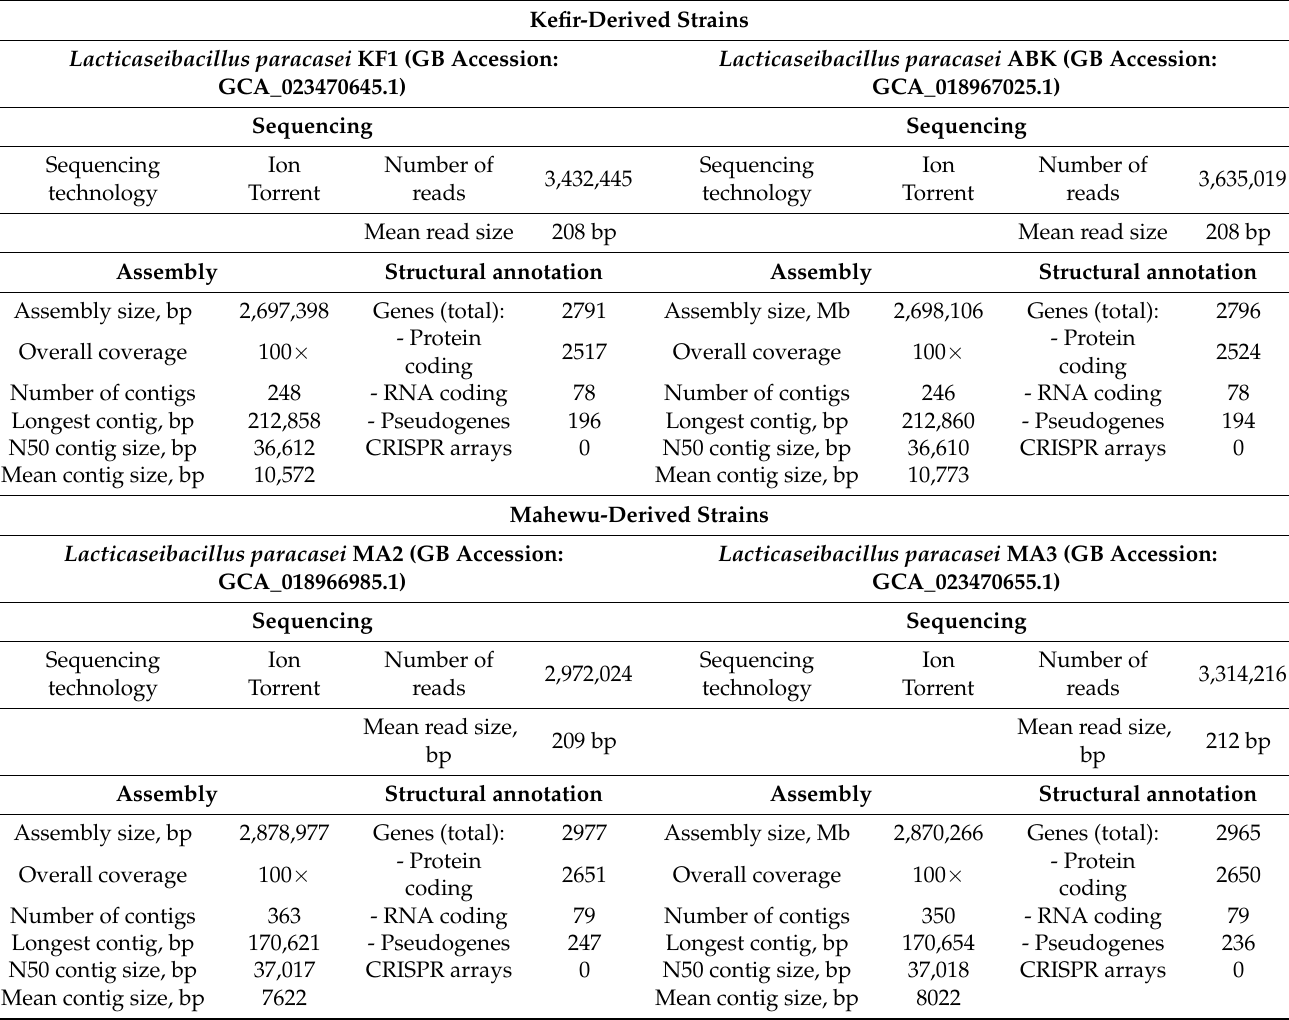
Table 2. Data on the genome sequencing of the kefir-derived (KF1 and ABK) and mahewu-derived (MA2 and MA3) strains of L. paracasei